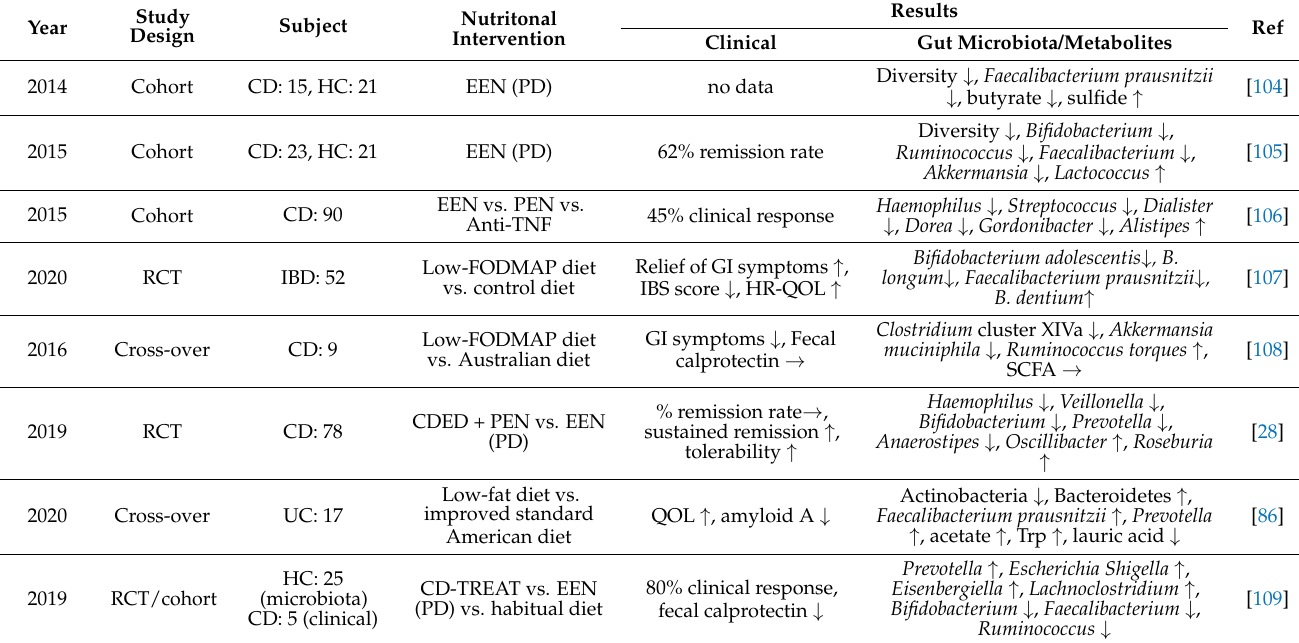
Table 1. The impact of dietary intervention on the gut microbiota in